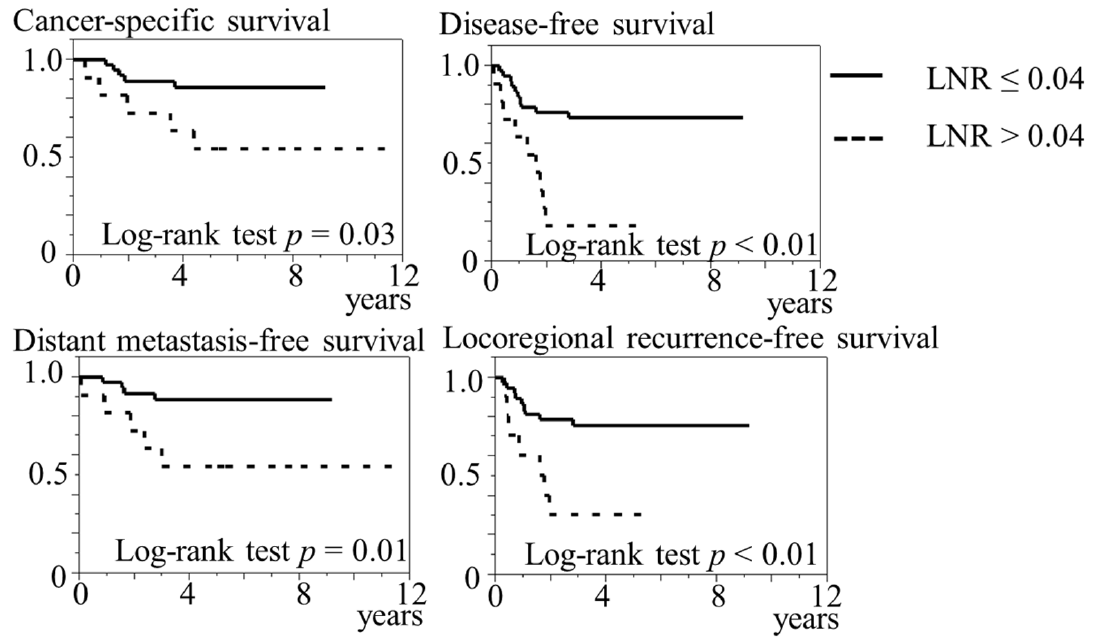
Figure 3. Kaplan–Meier curves in 49 patients were divided into two groups of lymph node ratios. LNR = lymph node ratio.